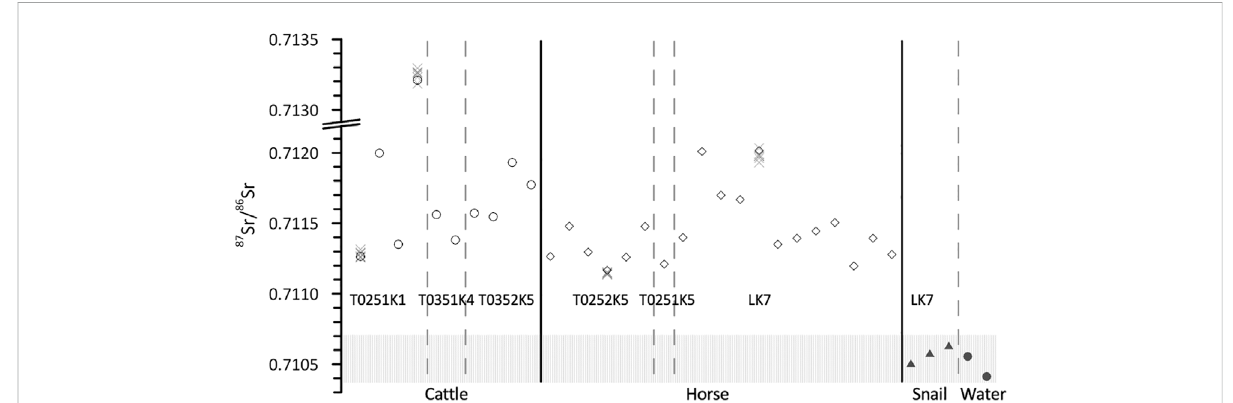
Strontiumisotope( 87 Sr/ 86 Sr)resultsfromXuechisite.Resultsarearrangedbypitswherethesampleswerecollected.Opencirclesanddiamonds representcattleandhorses,respectively,andthecrossesbehindtheindividualarethemeasurementsofitssequentialsamples.Shadedtrianglesand circles indicate snails and water samples, and the shaded area represents the estimated “ local ” 87 Sr/ 86 Sr range based on the shaded